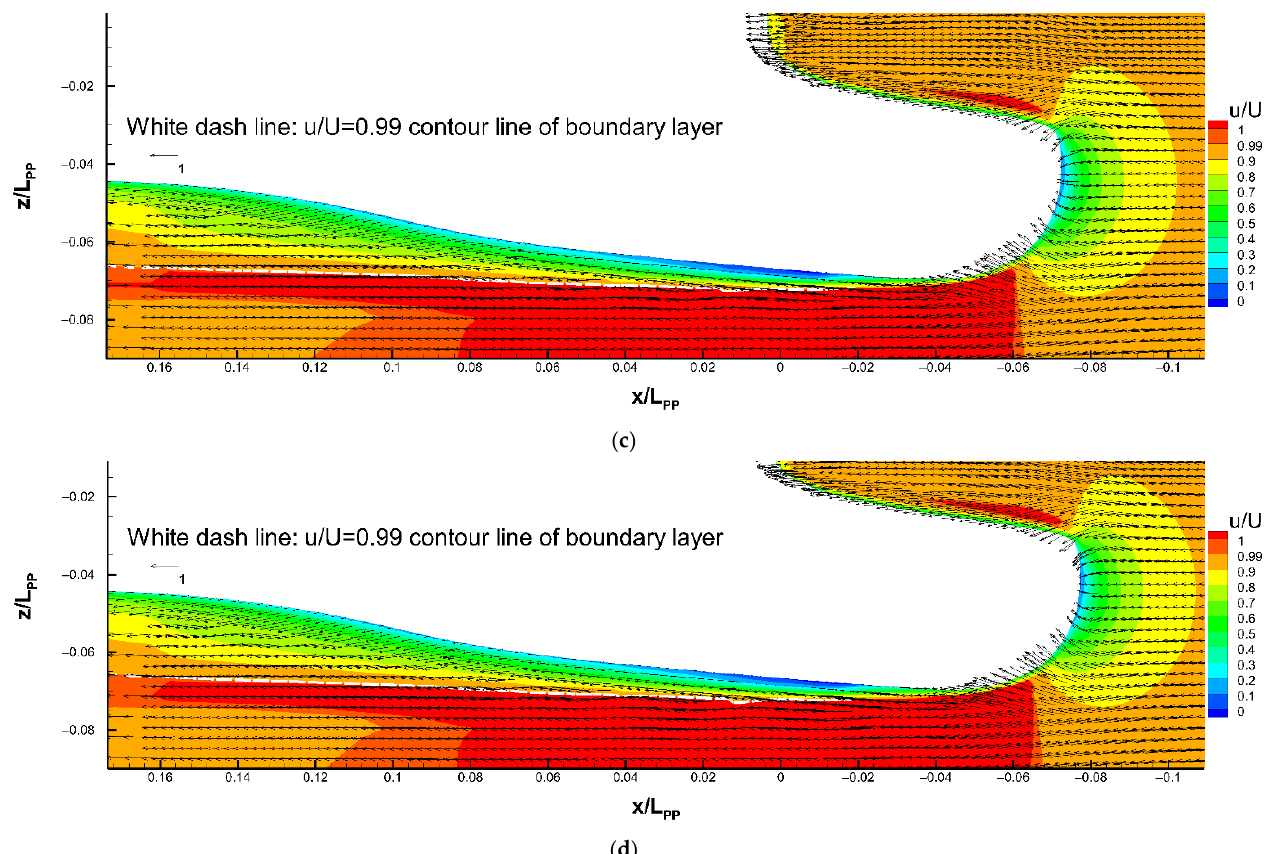
Figure 12. Velocity flow field around the sonar dome (on y = 0 plane): ( a ) F0; ( b ) F0.14; ( c ) F0.225; ( d ) F0.24. U = U 0